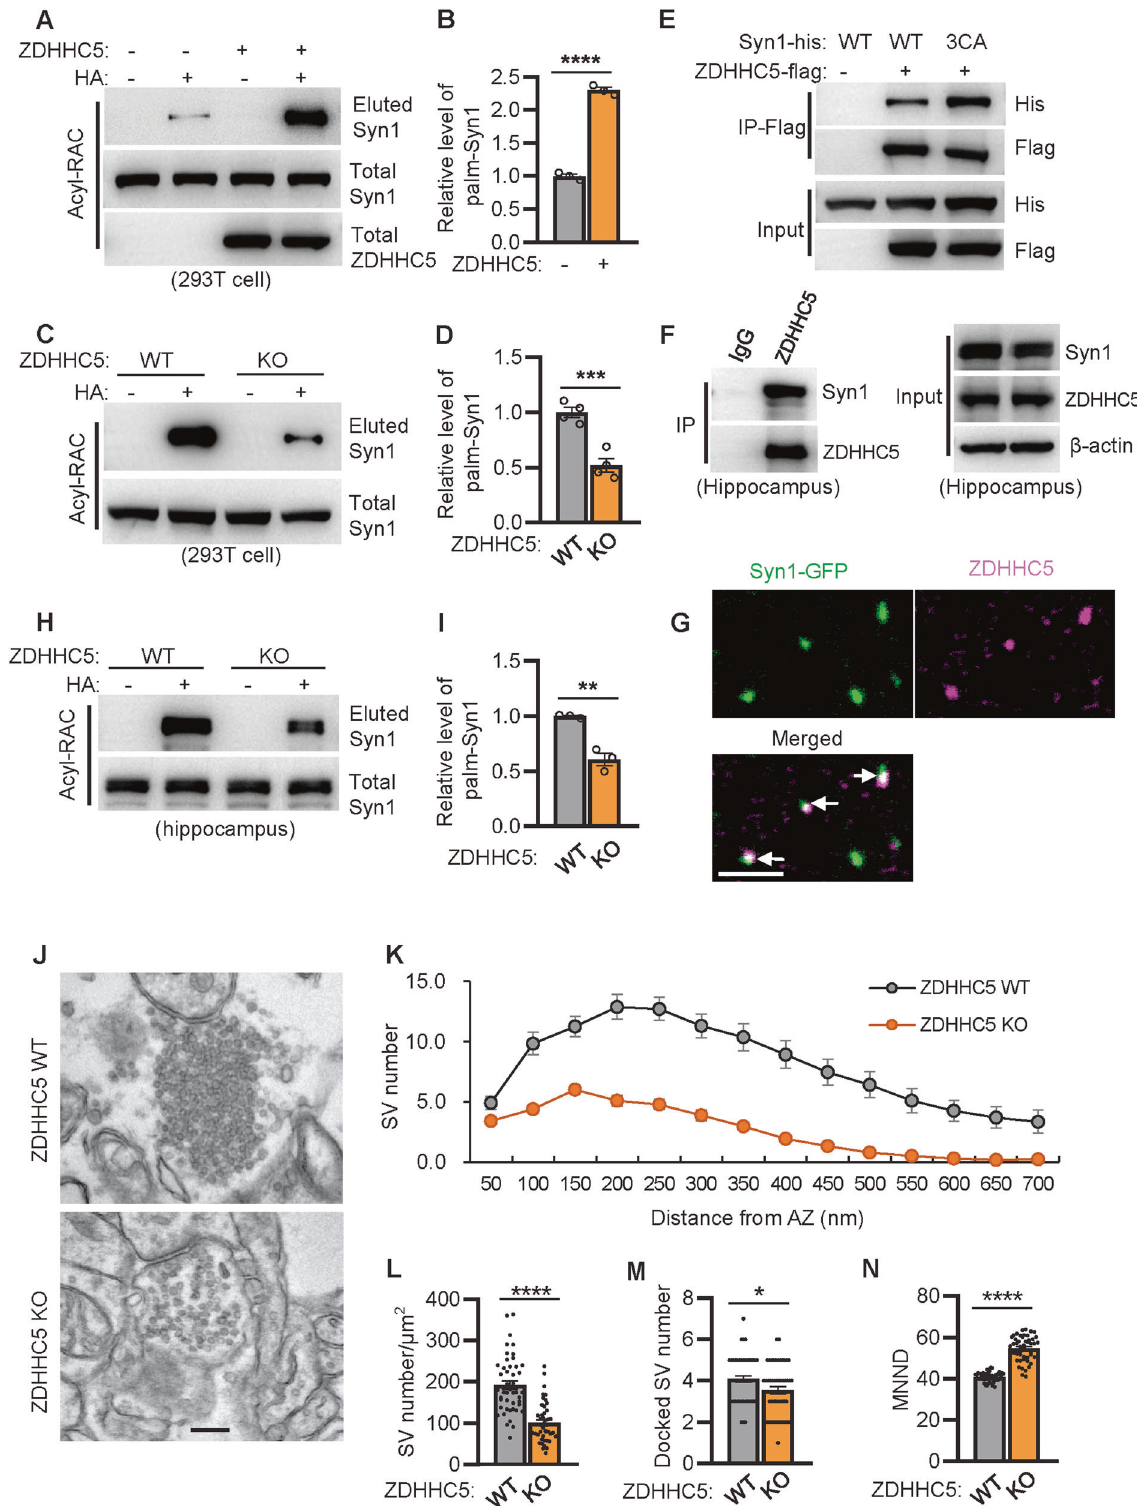
Syn1 is phosphorylated and disassociates from SVs and F-actin to mobilize SVs for exocytosis [4, 20 – 22]. However, how the dynamic phosphorylation of Syn1 might modulate its binding with SVs and F-actin relies on the observation that S9-phosphorylation in Syn1 might regulate its protein conformational remodeling [5, 23]. Here,